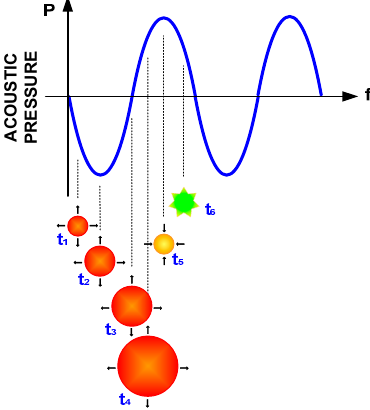
Figure 9. Bubble generation, transition, growth and collapse.